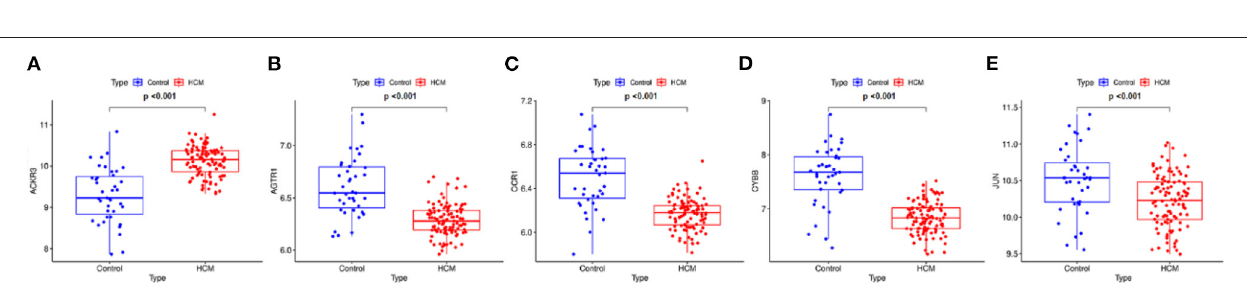
FIGURE 4 | Feature immune-related genes identified and correlation analysis. (A) The optimal lambda selection by LASSO. (B) The coefficient profiles of the six hub genes. (C) Feature IRGs selected by Boruta arithmetic. Genes in green are regarded as important feature IRGs while neutral in yellow and are rejected in red according to the score of feature importance. (D) The intersection result of LASSO and Boruta arithmetic. (E) The correlation analysis of the feature IRGs.